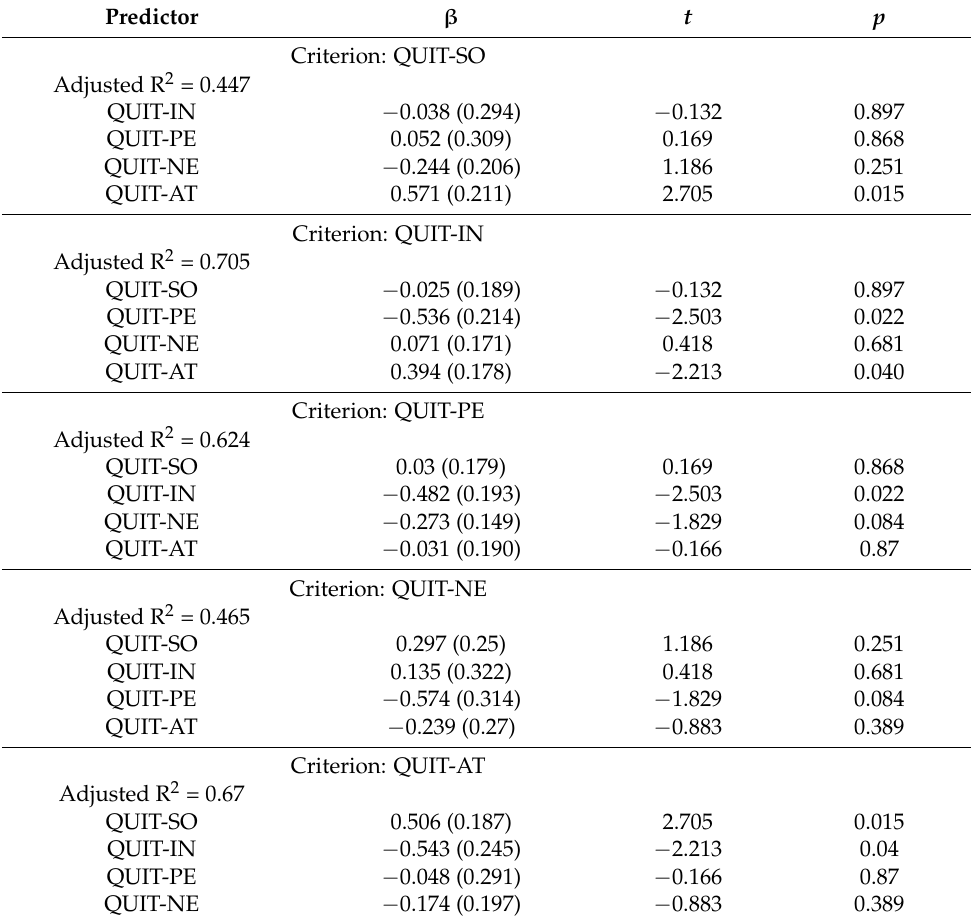
Table 3. GLM regression analyses predicting QUIT-SO, QUIT-IN, QUIT-PE, QUIT-NE and QUIT-AT subscales score from the other QUIT subscales for Mindfulness sample post-intervention ( n = 23).